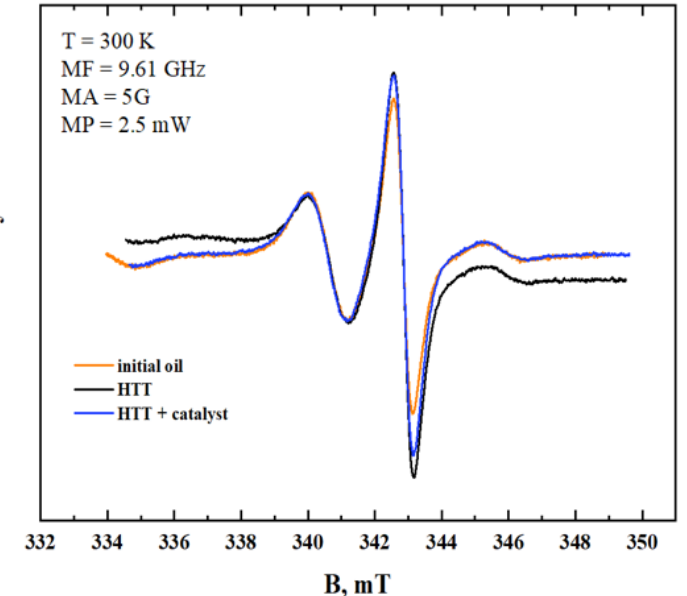
Figure 9. EPR spectra of free radicals in the composition of initial oil sample and after hydrothermal treatment in the absence and presence of the catalyst.